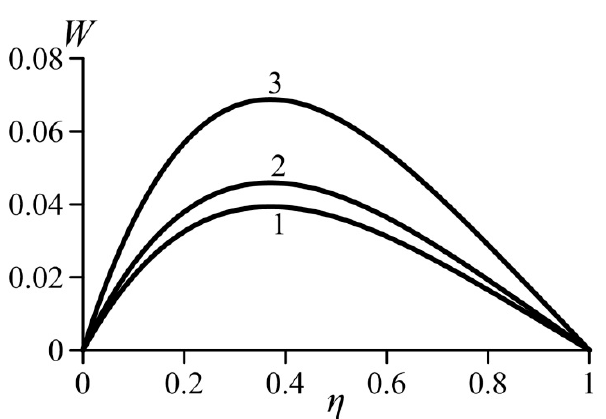
= βθ = βθ . 1—ideal . 1—ideal w w